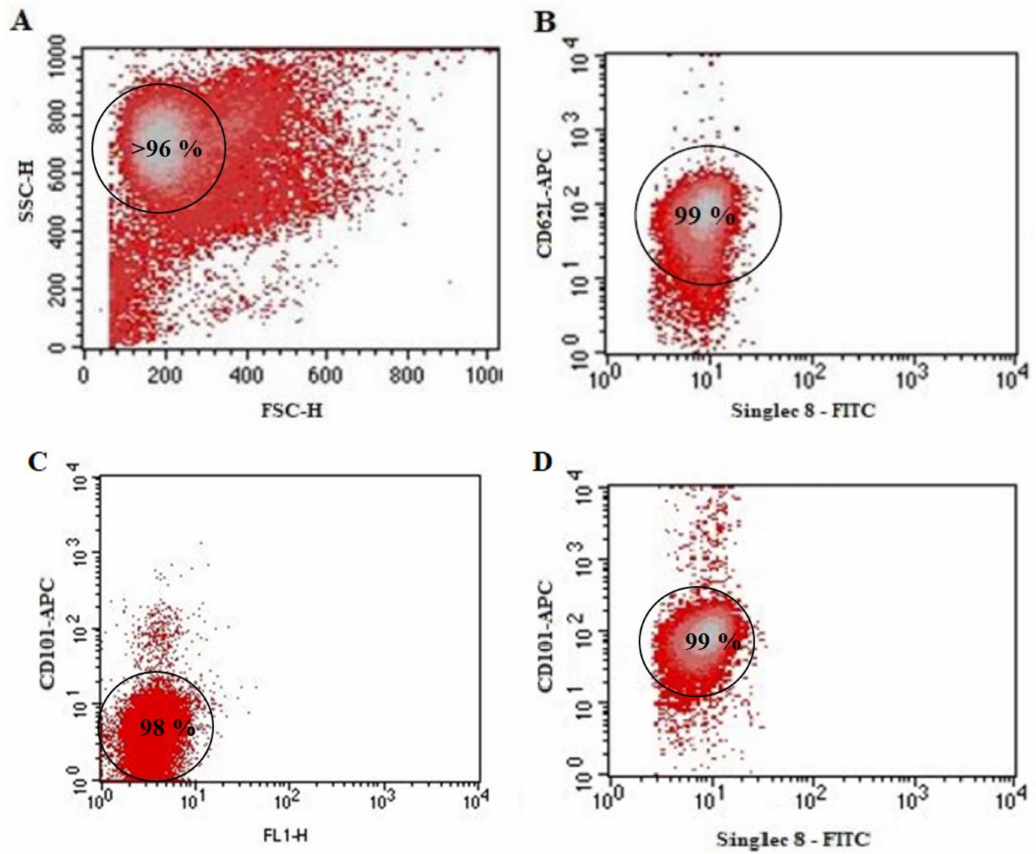
Figure 3. Confirmation of separated eosinophils subtypes by flow cytometry. ( A ) Total enriched eosinophils population; ( B ) separated rEOS population, labeled with CD62L-APC antibody; ( C ) rEOS population labeled with CD101-APC antibody; ( D ) iEOS population labeled with CD101-APC antibody parts; ( B – D ) a homogeneous rEOS or iEOS population was used after the final magnetic separation